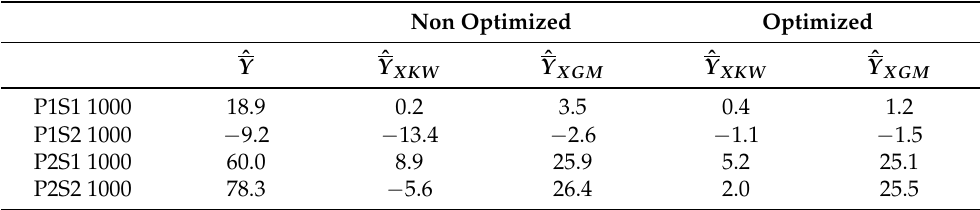
Table 3. Relative bias (%) for each optimized case.